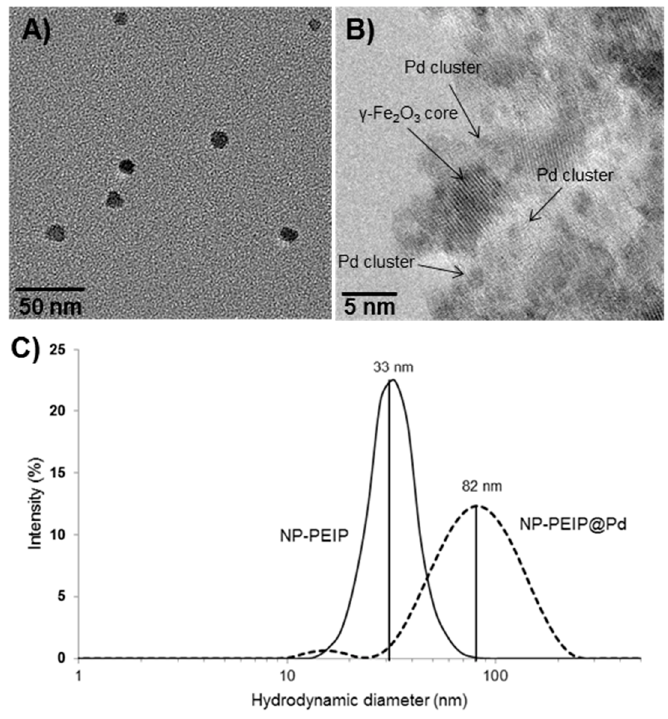
Figure 2. ( A ) Maghemite nanoparticles were found to be 7.5 nm in diameter, with a quasi-spherical shape; ( B ) The core maghemite is distinguished by the lattice fringes. Around, smaller dark spots are attributed to the palladium clusters; ( C ) Hydrodynamic diameter before and after the loading of palladium.